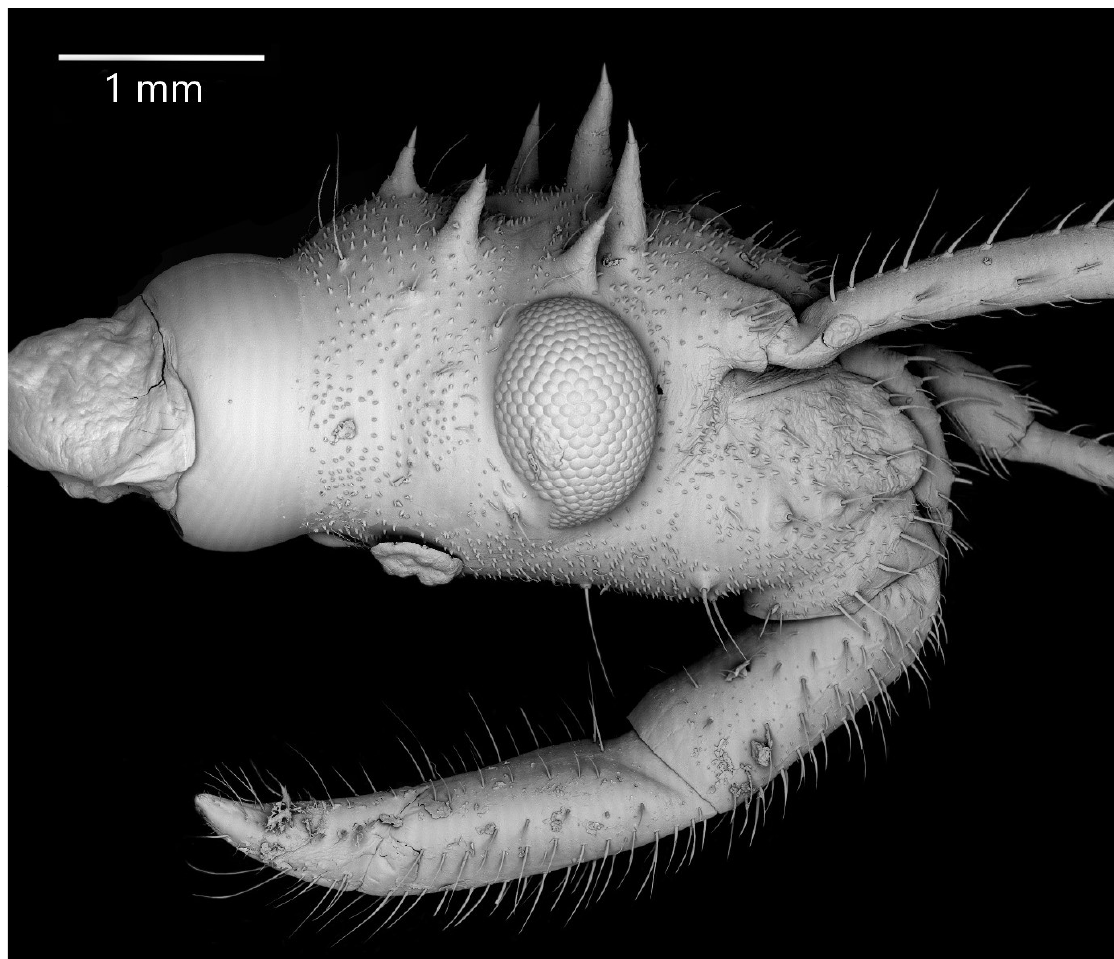
Figure 20. Psyttala horrida (Stål, 1865), third instar, head in lateral view, SEM.